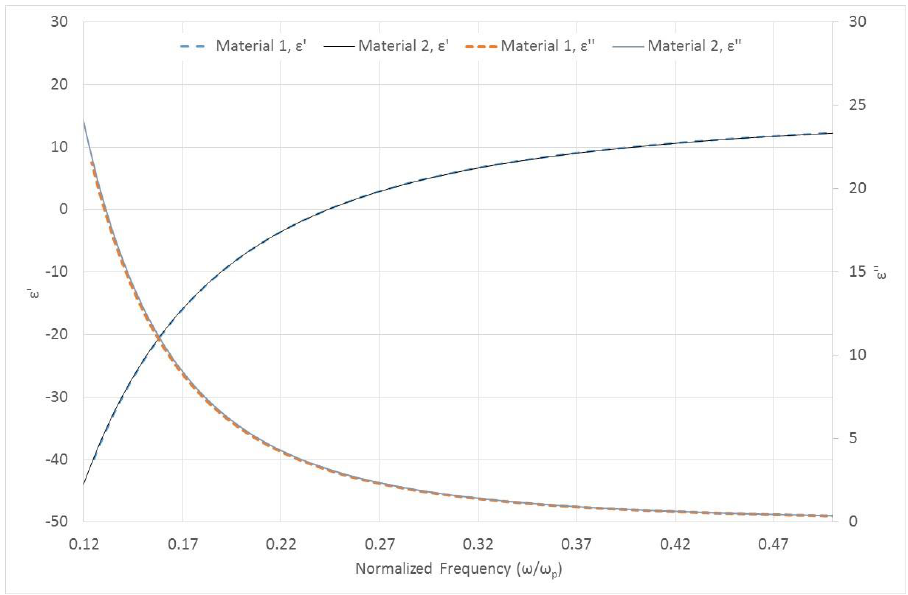
Figure 8. Real and Imaginary parts of the dielectric constant for materials number 1 and 2 in Table 2 (Samples 9338 and 9336 in reference [33]). The frequency is normalized to the plasma frequency. For these chemical vapor deposition (CVD) fabricated samples it is seen that the normalized permittivities overlay each other, enabling scaling.